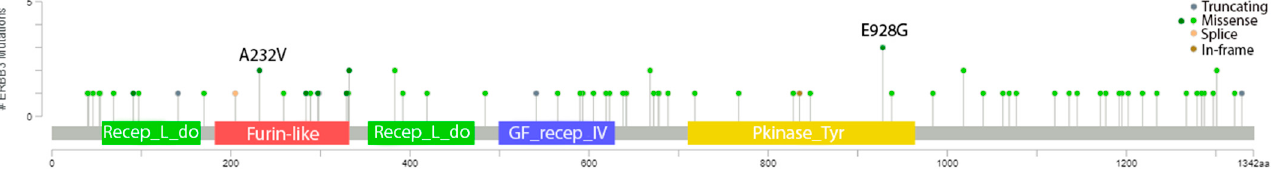
Figure 6. The frequency of HER3 mutations in lung cancer and their locations within the HER3 receptor. Figure rendered in cBioPortal using multiple studies (n = 7204). Gray indicates truncating mutation, green indicates a missense mutation, yellow indicates splice mutation, and brown indicates an in-frame mutation [27,28] .